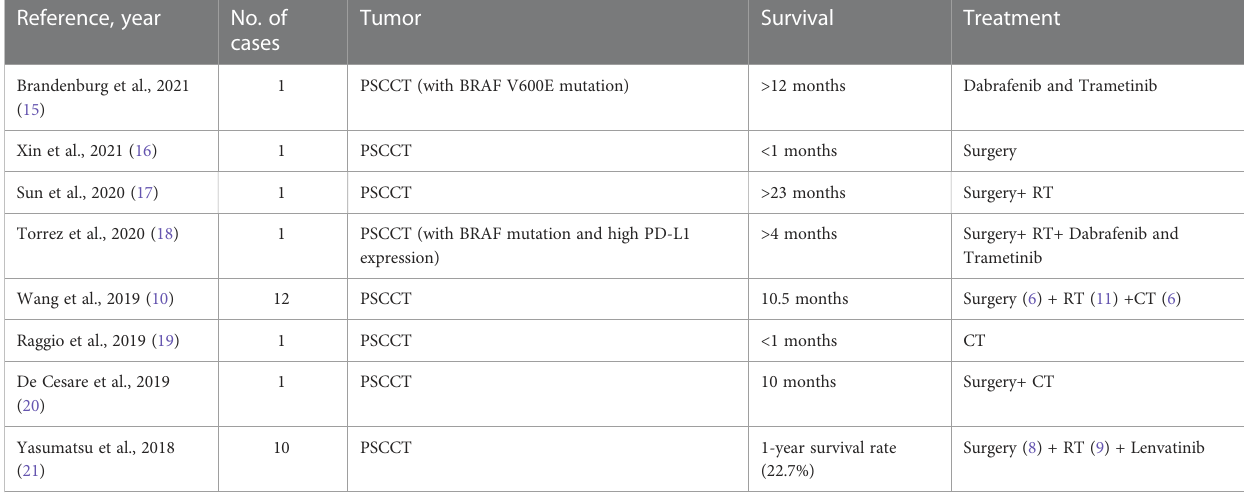
TABLE 1 Treatment and survival of primary squamous cell carcinoma of the